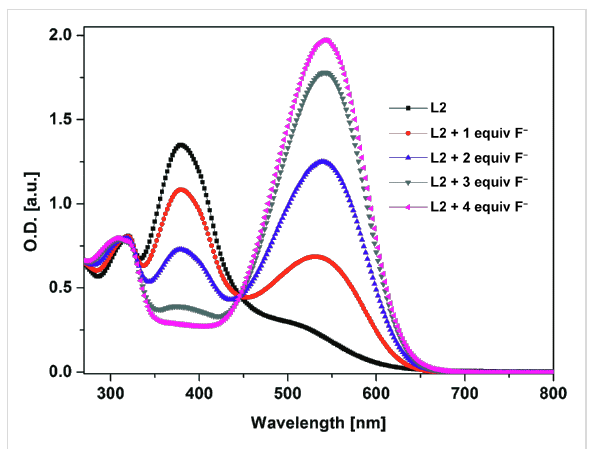
Figure 7: UV–visible spectral changes of ligand L2 (2 × 10 − 5 M in CH 2 Cl 2 /CH 3 CN, 9/1) upon addition of TBAF.